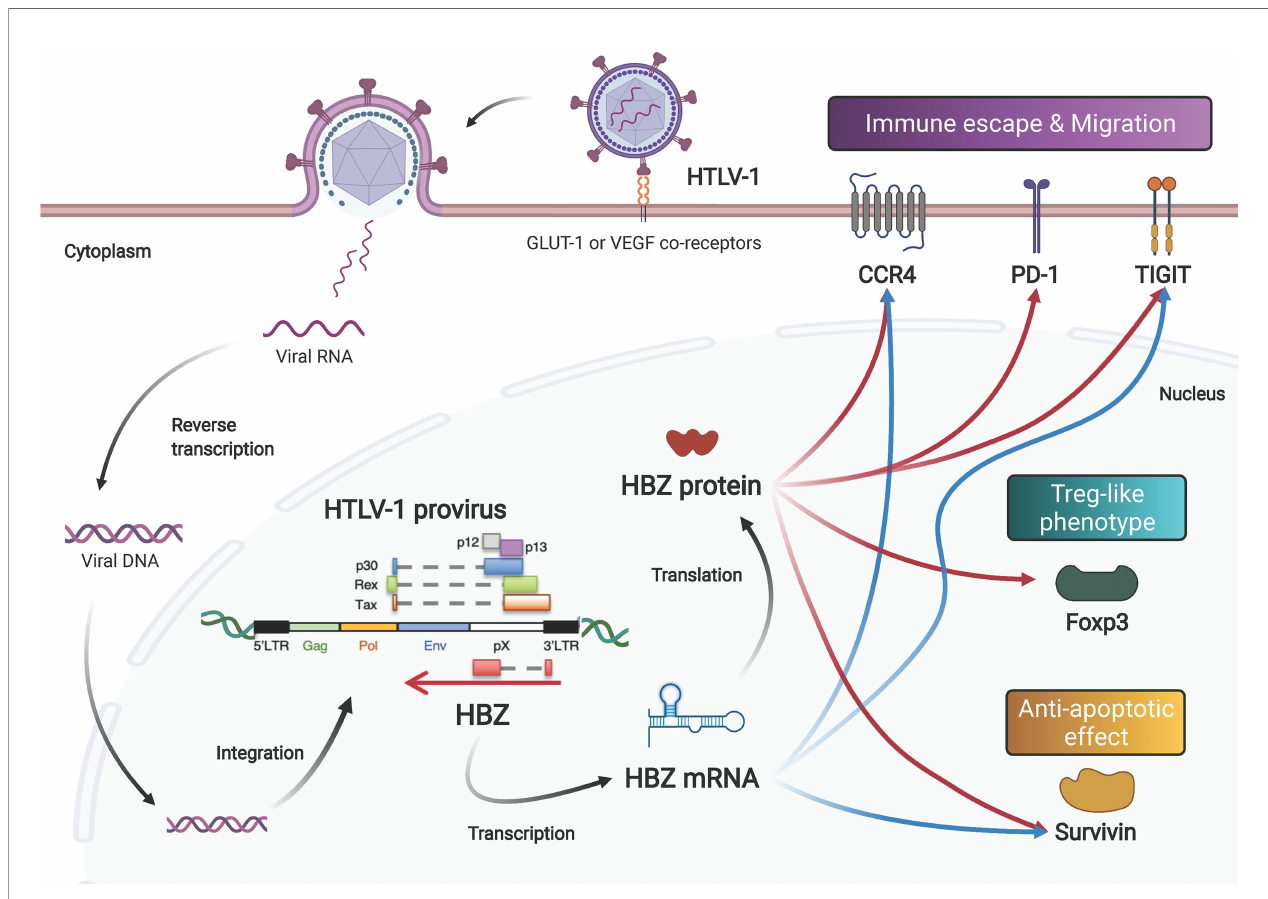
FIGURE 1 | Both the mRNA and protein products of the HTLV-1 HBZ gene function to induce proliferation, survival, and phenotype change of infected cells. After infection via its receptors (GLUT-1, neuropilin-1 and heparan sulfate proteoglycan), the HTLV-1 genome is integrated into the host ’ s DNA. HTLV-1 encodes viral genes in the sense and antisense strand of the provirus. The antisense gene, HBZ , is transcribed into mRNA, and subsequently translated into protein. Both the mRNA and the protein enhance the expression levels of CCR4 , Tigit and Survivin . In addition, HBZ protein enhances transcription of PD-1 and Foxp3